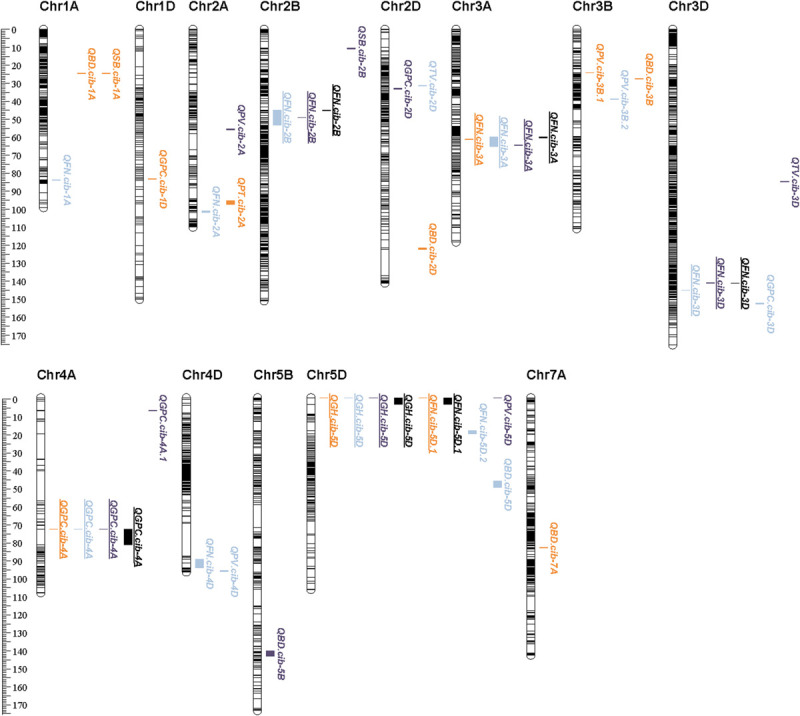
Distribution of QTLs on chromosomes. Orange-marked QTLs were detected in E1, blue ones were detected in E2, purple ones were detected in E3, and black ones were detected by BLUP. Underlined QTLs denote those that could be detected in at least two environments or by BLUP.